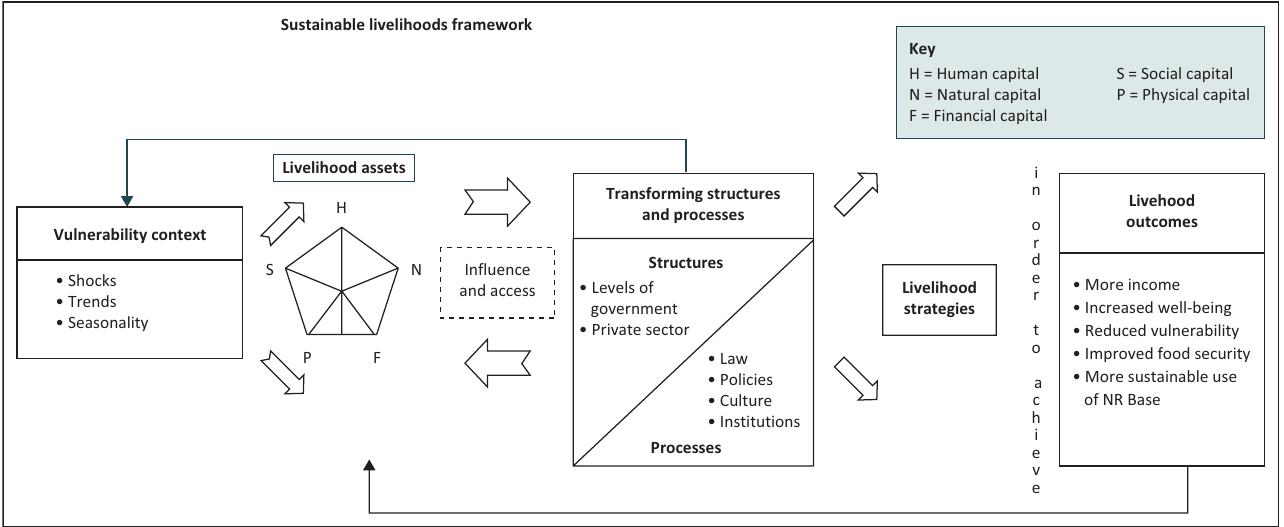
FIGURE 1: The sustainable livelihoods framework.